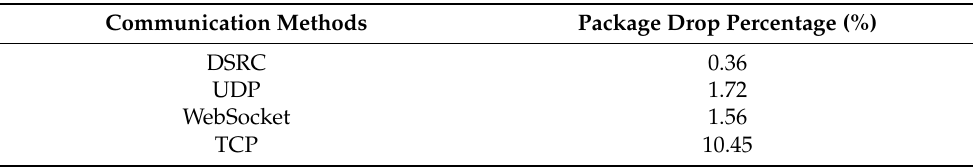
Table 1. Summary of Package Drop Percentage comparison between the four communication meth- ods utilized in Experiment #2.